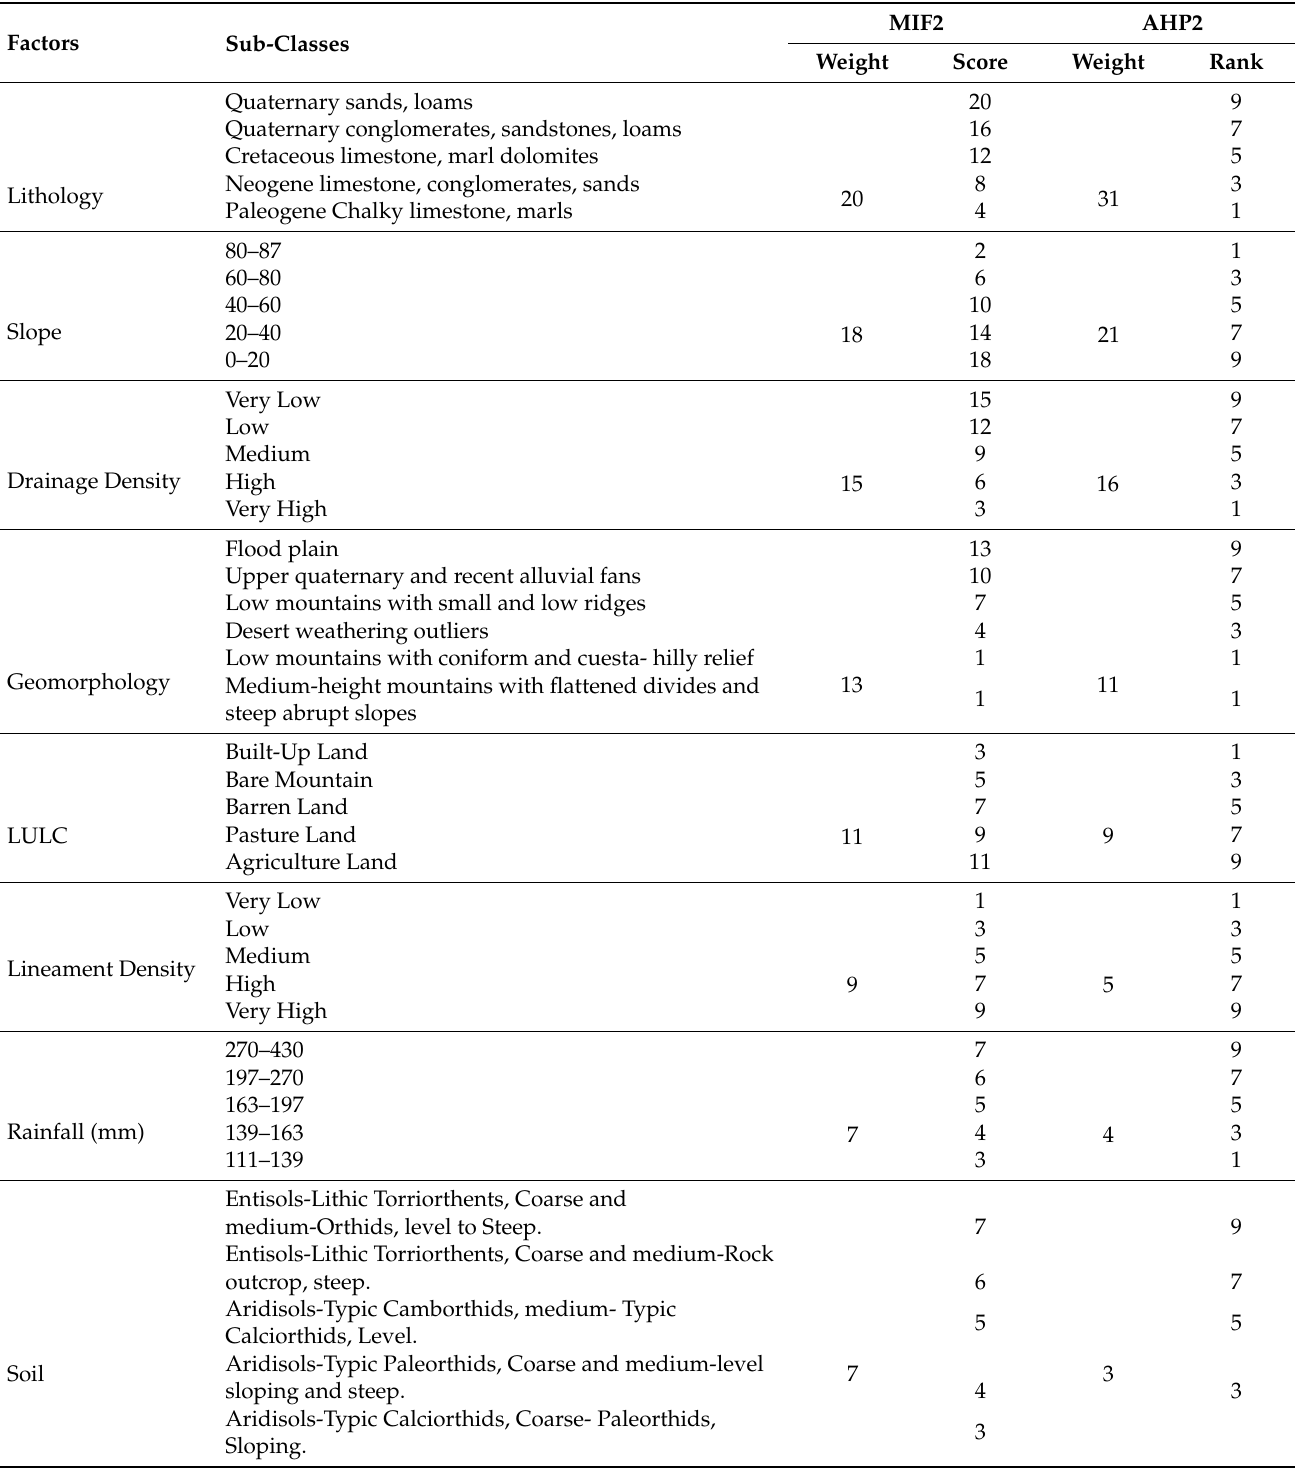
Table A2. Weight and scores of specific characteristics in (MIF2 and AHP2) are assigned to factors that influence